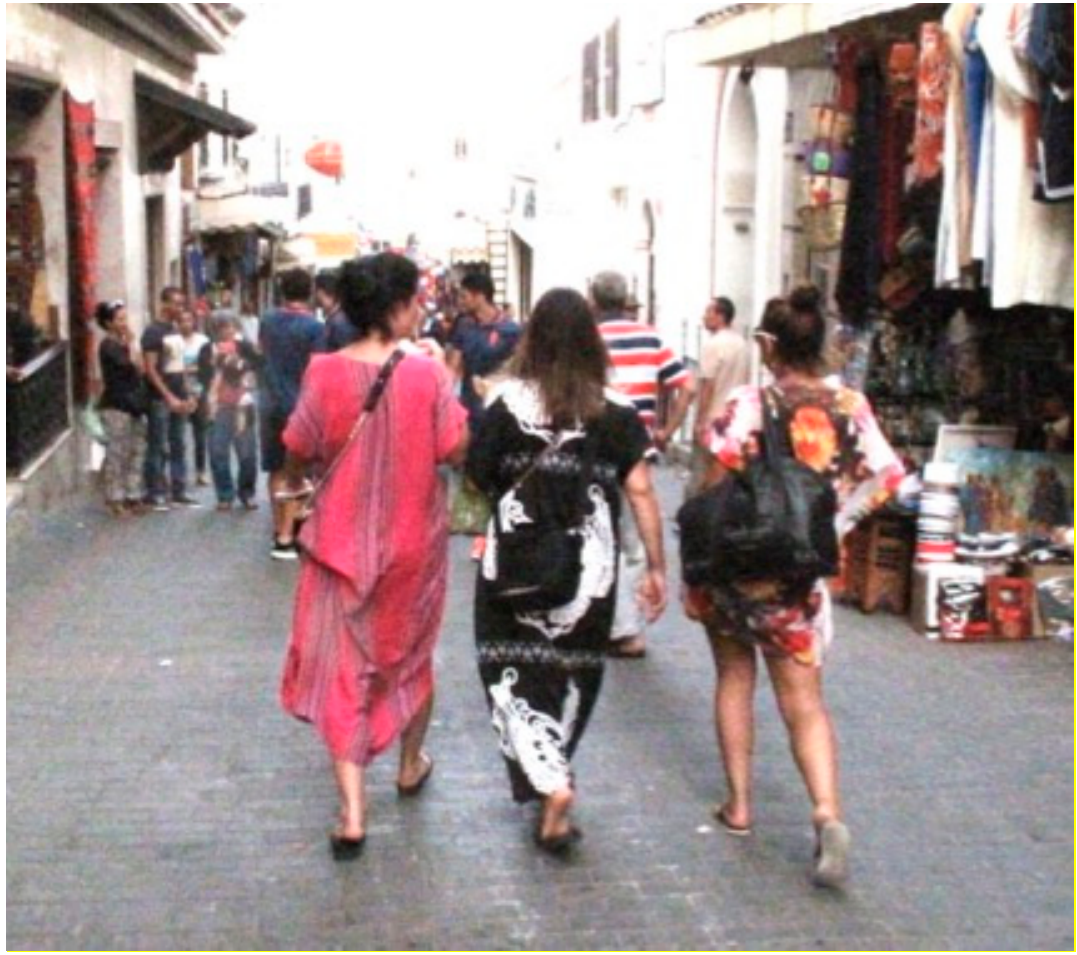
Figure 2. Women walking in central Tangier, summer 2015 (photograph by the author).